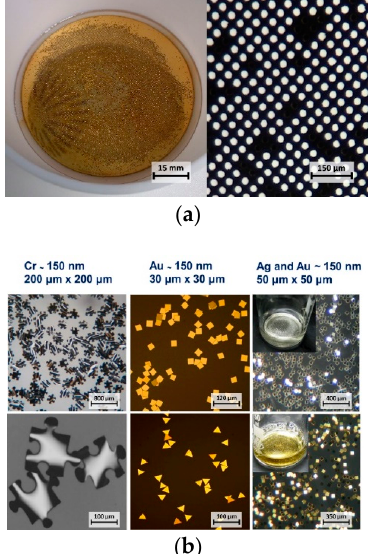
Figure 2. ( a ) Glass substrate during the stripping stage and the detail of the surface after the release of nano-platelets (30 μ m diameter). Dark spots between the white circles indicate that some of the nano-platelets were not completely released. ( b ) Examples of different shapes, sizes and materials. The inserts in the pictures on the right show the corresponding nano-platelets resuspended in a buffer.